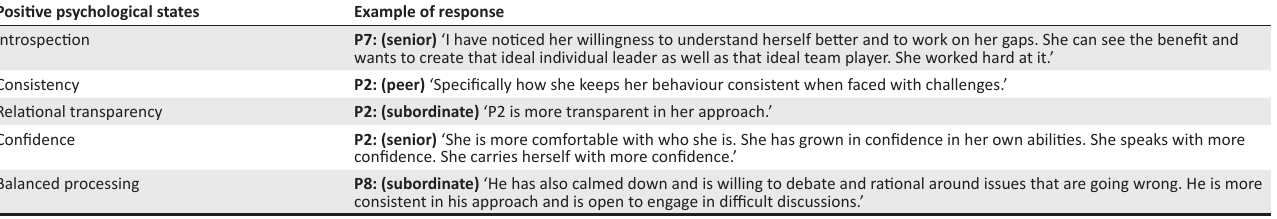
TABLE 2: Examples of positive psychological states as noted by secondary participants. Positive psychological states